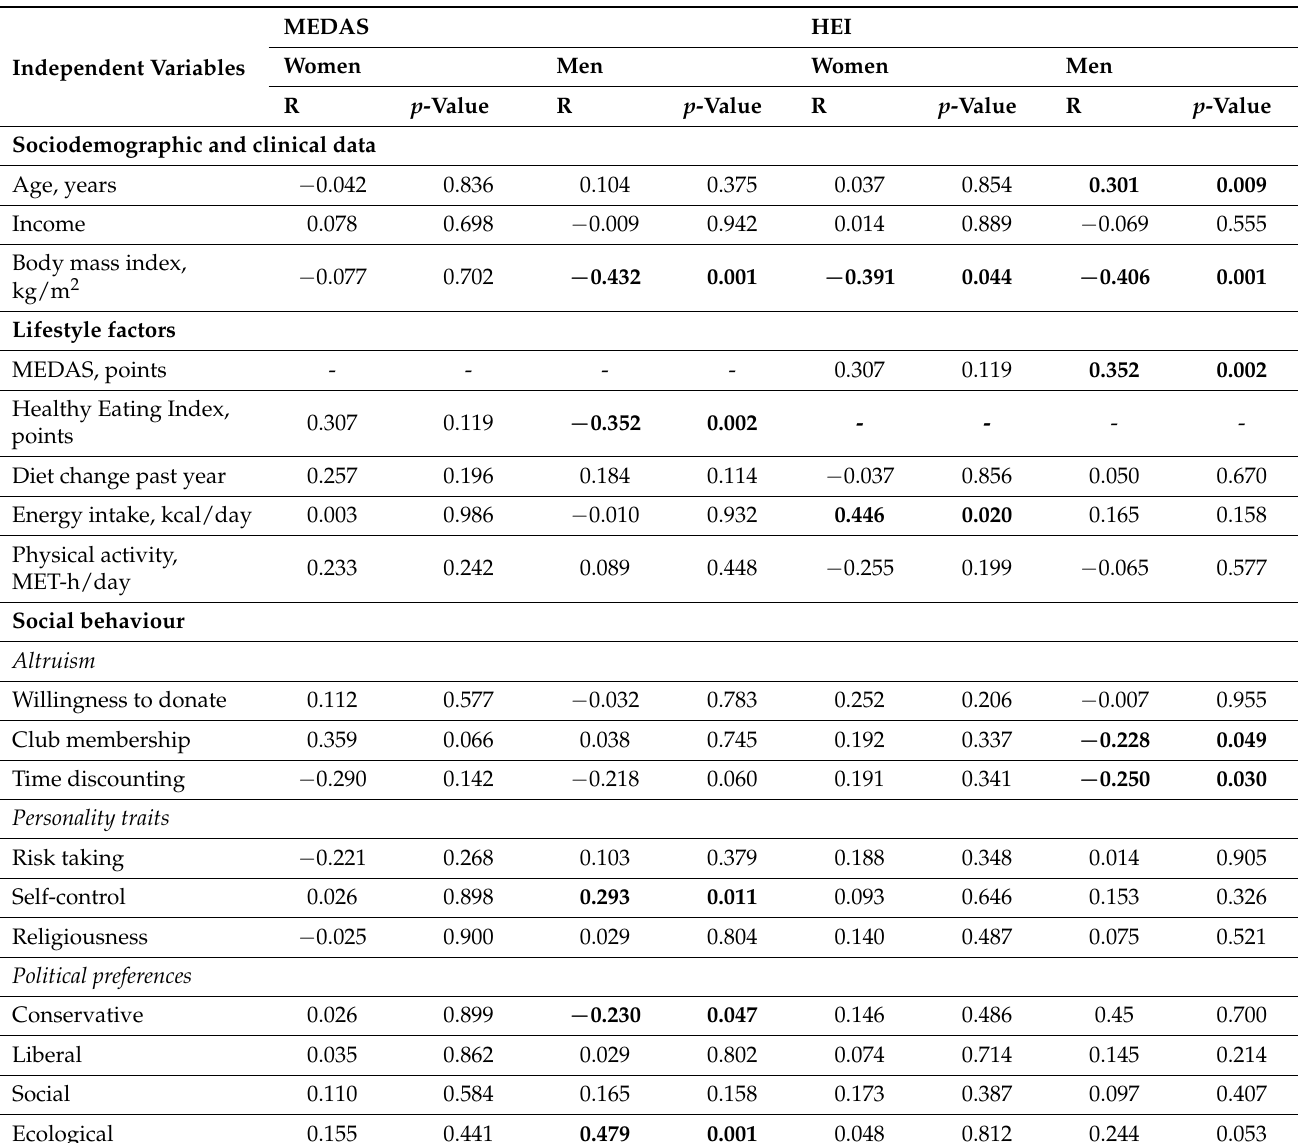
Table 2. Correlations of MEDAS and HEI with independent variables by